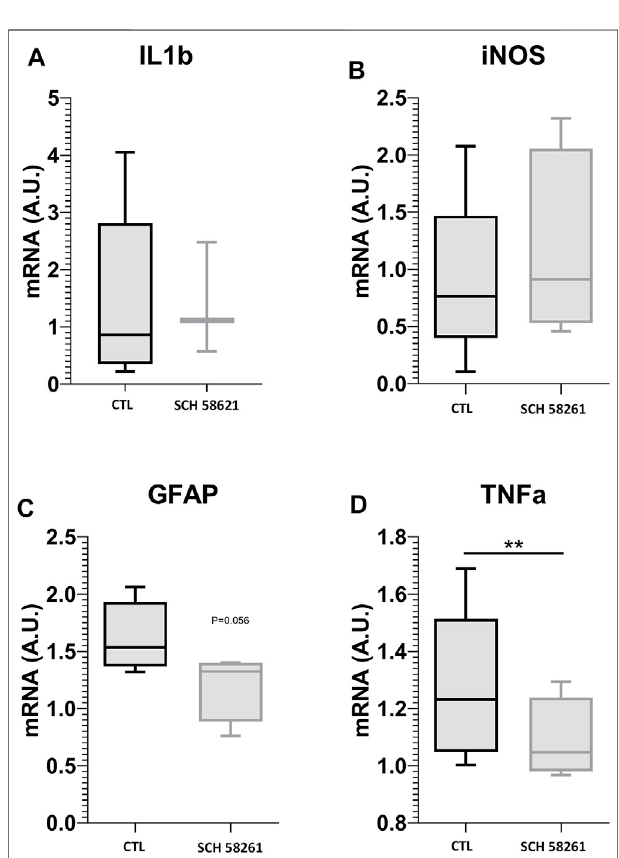
FIGURE 8 | qRT-PCR for IL-1 β (A) , iNOS (B) , GFAP (C) , and TNF- α (D) mRNAs in retinas from SCH58261 and their respective CTL. Boxes represent 25 and 75 percentiles, whiskers represent minimum and maximum values, and transverse lines represent medians. Student ’ s t -test, * p < 0.05; ** p <